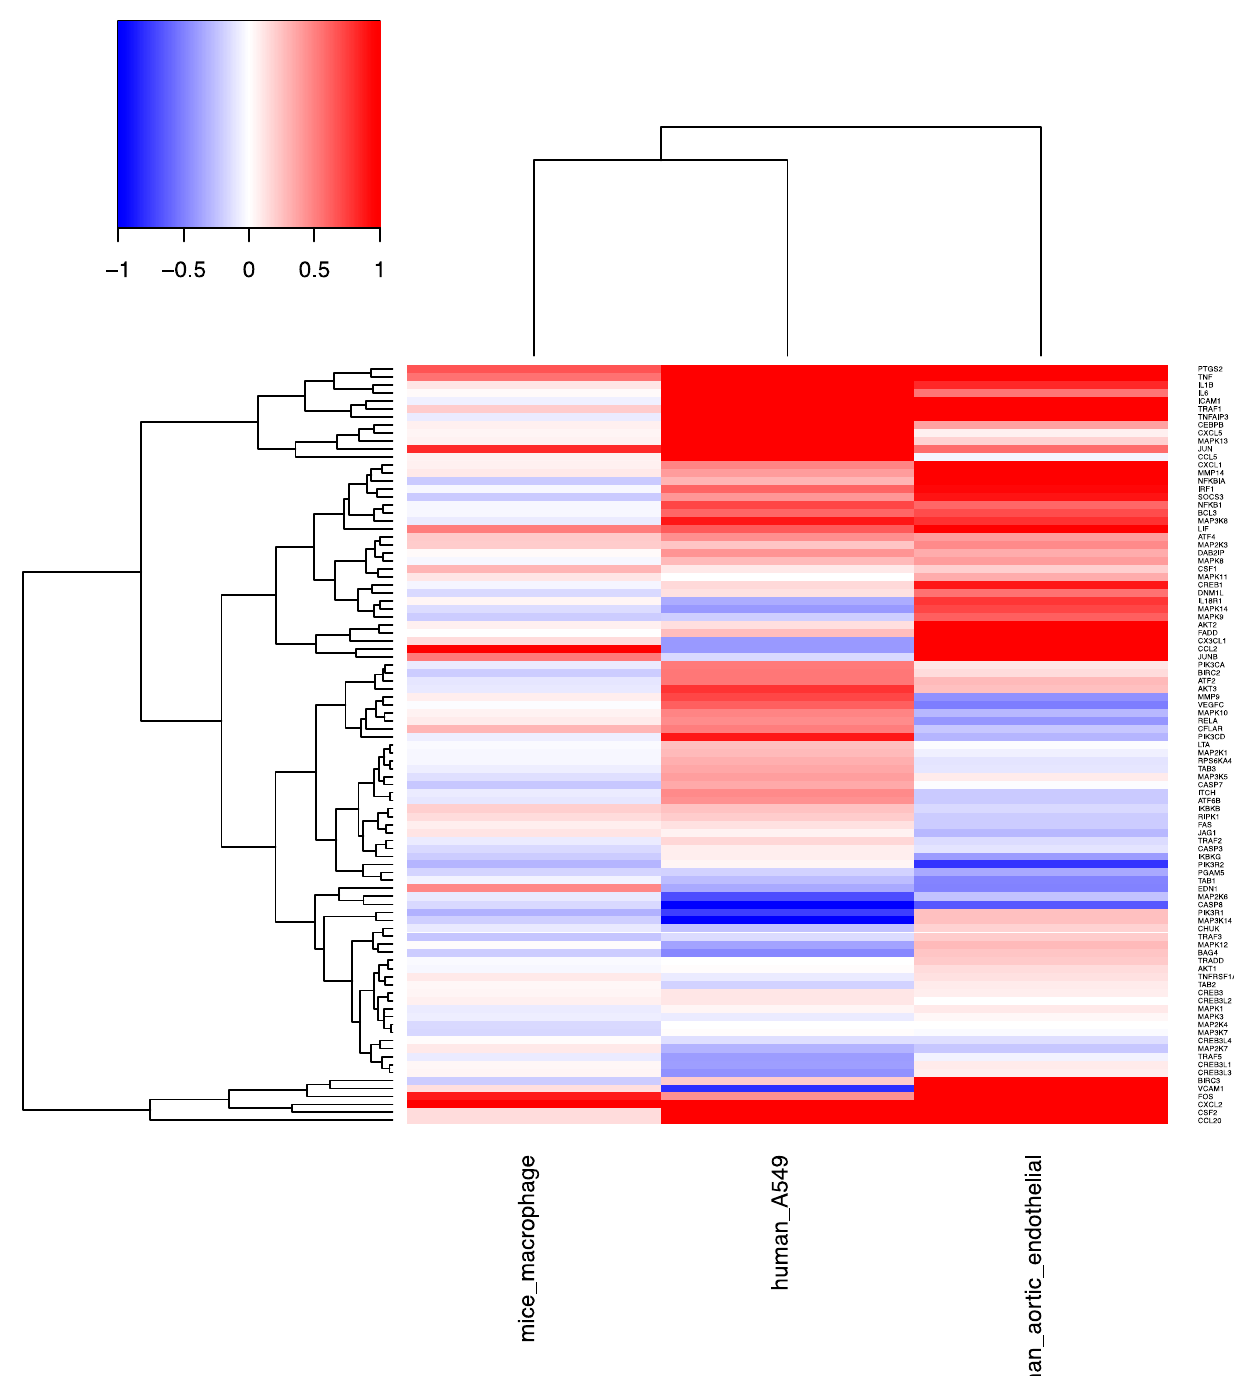
Figure 3. Venn diagrams of identified upregulated genes in TNF signaling pathway ( A ) and MAPK signaling pathway ( B ) that are shared between the three microarray datasets. Set1 corre- sponds to the human aortic endothelial cells, set2 corresponds to the lung-derived macrophages, and set3 corresponds to the A549 lung cancer cells.